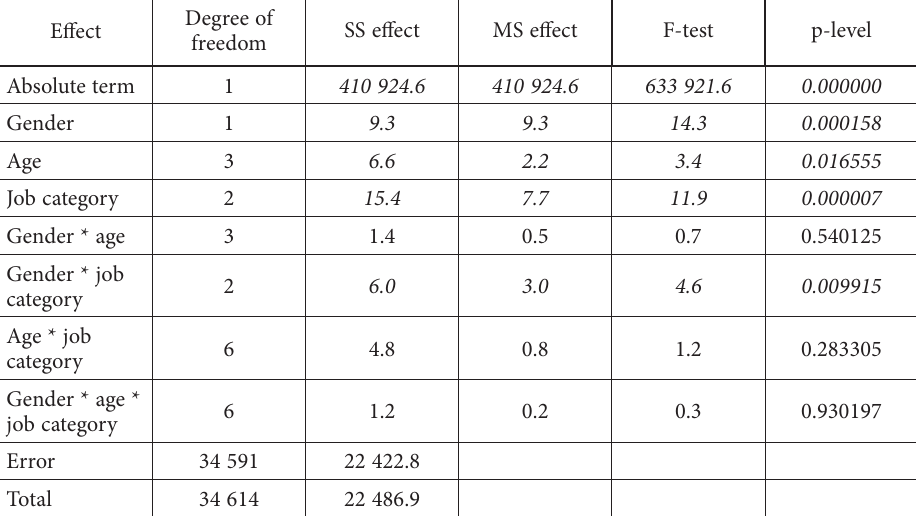
Table 4. One dimensional results of the motivation factor basic